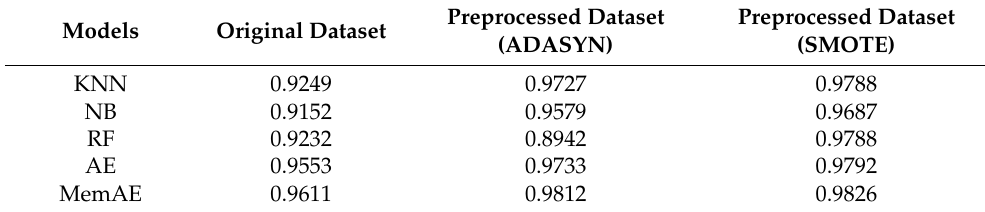
Table 6. AUROC performance for each dataset.